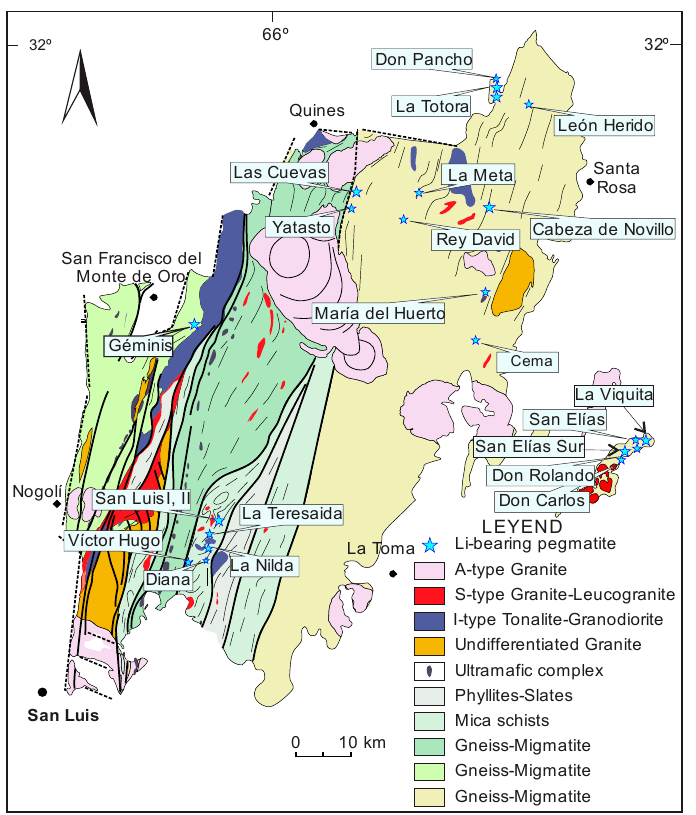
Figure 4. Geological map of the San Luis and La Estanzuela ranges with the distribution of the Li-bearing pegmatites (modified from [40]).